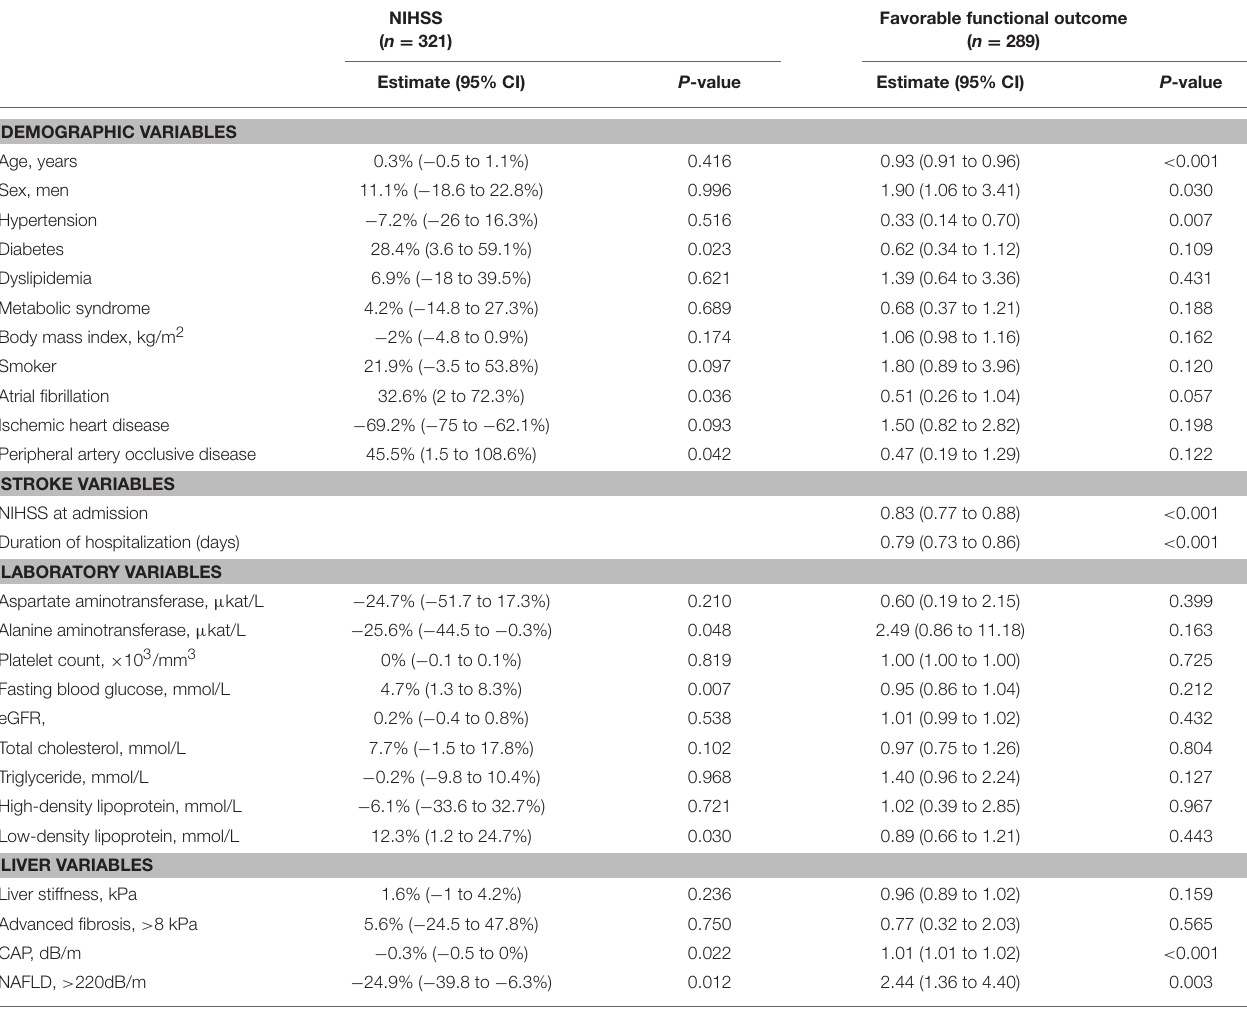
TABLE 2 | Univariate regression